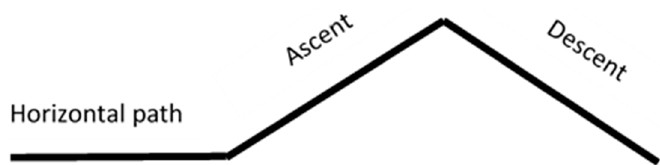
Figure 4. Schematic representation of a daily trip.